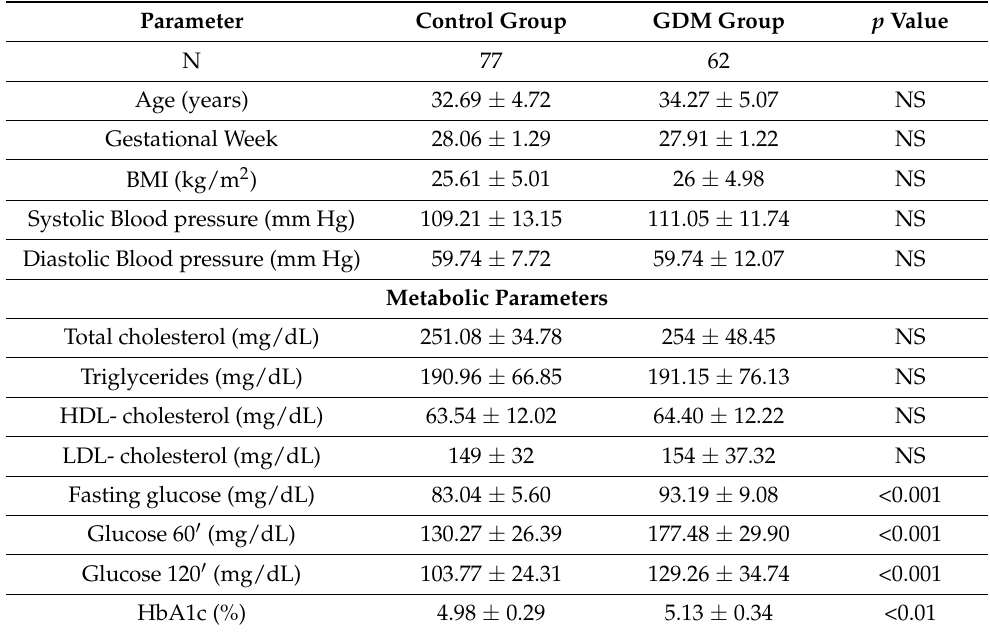
Table 1. Anthropometric and metabolic characteristic of the women included in the